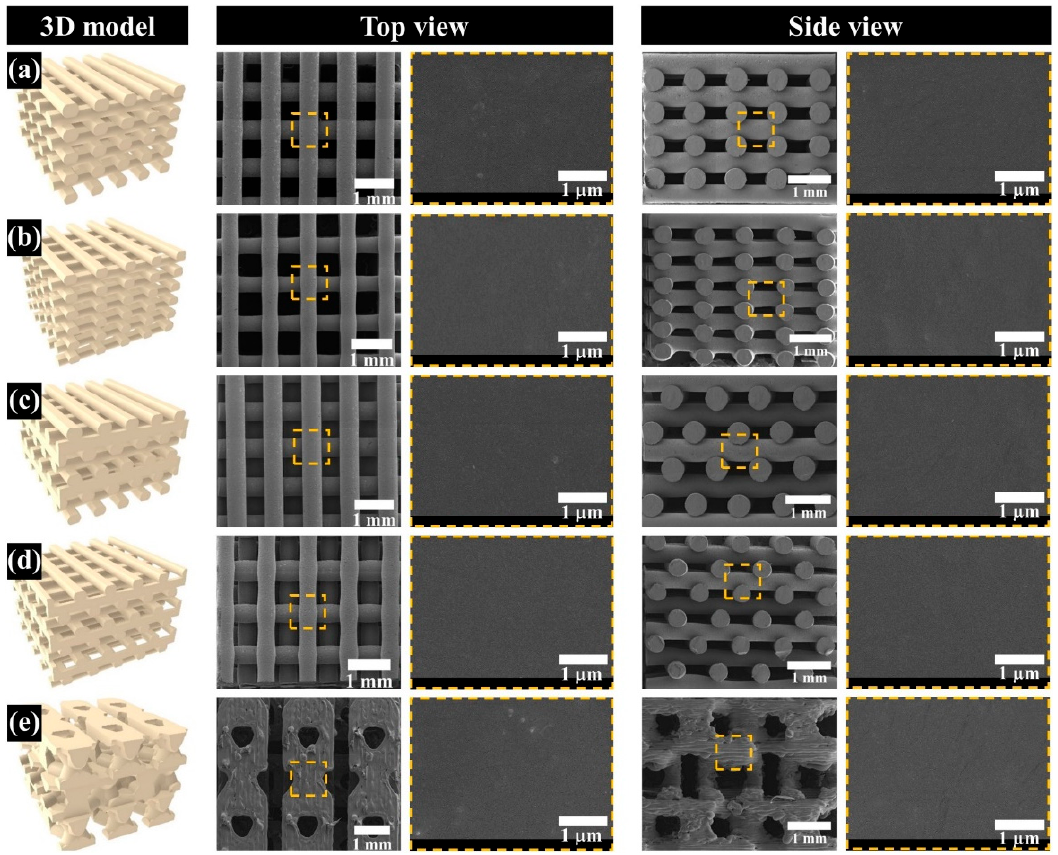
Figure 3. Three-D modeling, top-view, and side-view images of the fabricated scaffolds: ( a ) Conv 1 (similar pore size); ( b ) Conv 2 (similar porosity); ( c ) Offset 1 (similar pore size); ( d ) Offset 2 (similar porosity); ( e ) dual